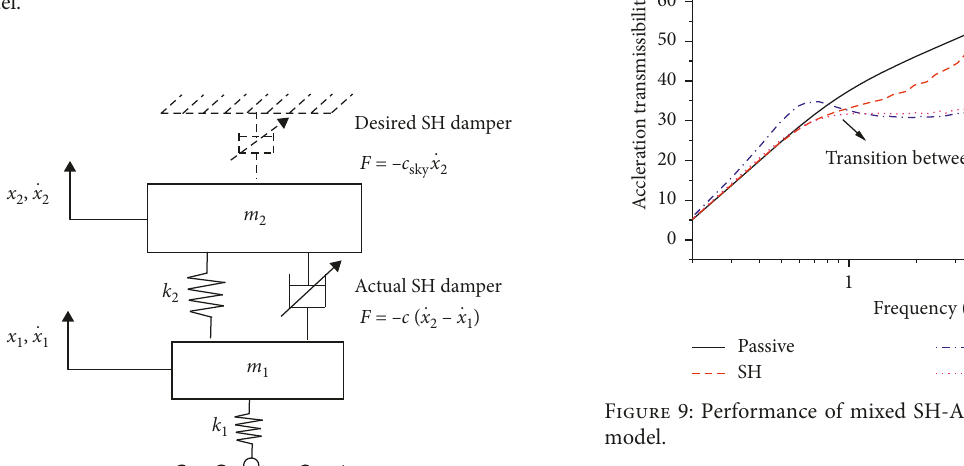
Figure 6: Derailment index and unloading ratio of the vehicle model.